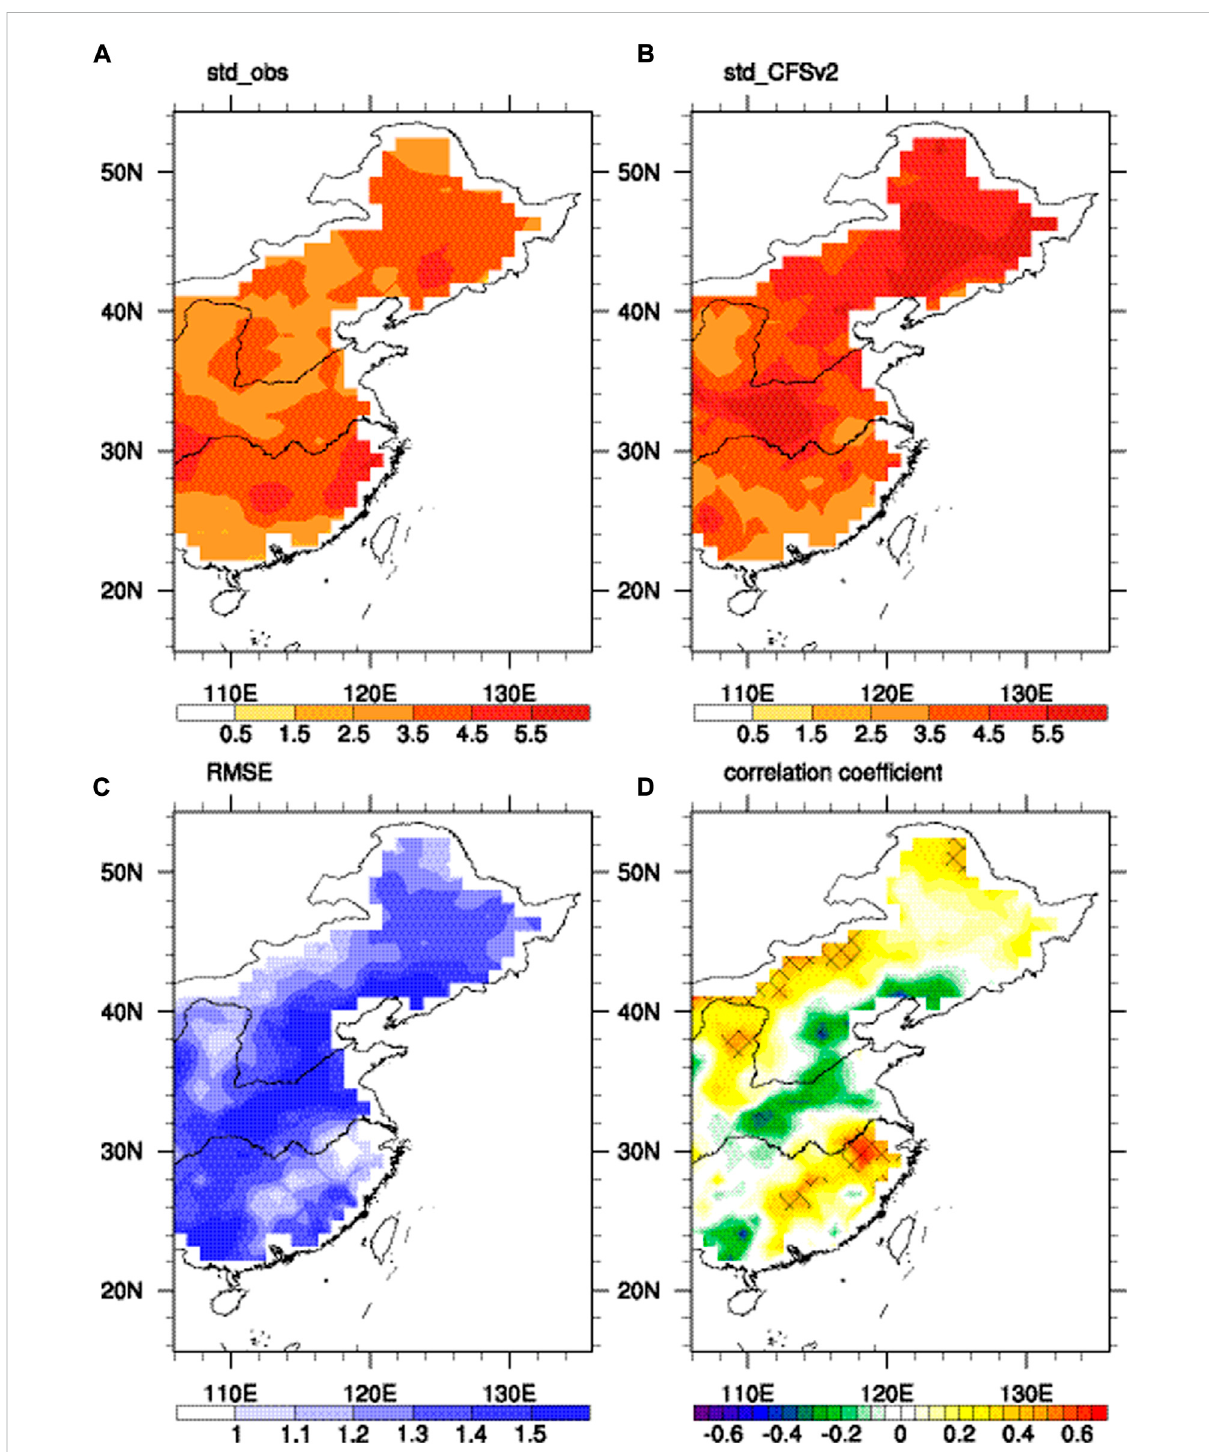
FIGURE 1 Standard deviation of FEHEs over eastern China during summer in (A) the observations and (B) the CFSv2 hindcasts. (C) The RMSE between the standardizedtime series ofsummer FEHEsintheobservationsand theCFSv2 hindcasts. (D) Timecorrelationcoef fi cients between summerFEHEsin the observations and the CFSv2 hindcasts. The meshes in (D) denote the correlation coef fi cients signi fi cant at the 95% con fi dence level based on Student ’ s t